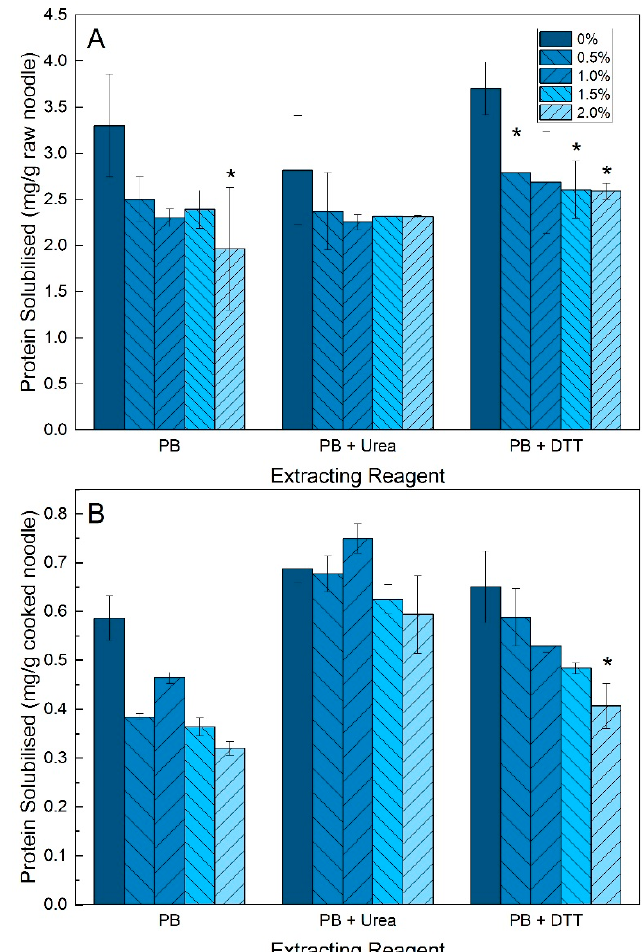
Figure 2. Protein solubility of ( A ) raw and ( B ) cooked noodles with 0%, 0.5%, 1.0%, 1.5% and 2.0% transglutaminase in extracting reagents phosphate buffer (PB; 0.1 M; pH 6.8), 8 M urea in PB (PB + Urea), 0.05 M dithiothreitol in PB (PB + DTT) and 0.05 M sodium dodecyl sulphate in PB (PB + SDS); * indicates significant difference ( p < 0.05) compared to control (0% TG) in the same extracting reagent group; error bars represent S.D. based on duplicates. Table 1. Onset, peak and end temperature ( ° C) and gelatinisation enthalpy (J/g) ( ± S.D.) of noodles at different transglutaminase (TG) concentrations (%).